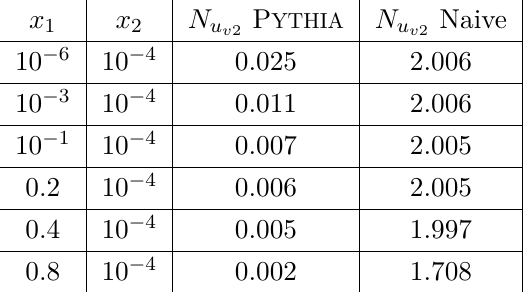
Table 9 . Integration over R uuu response function with respect to x 3 at fixed x 1 , x 2 . In the ideal situation when the GS sum rules are perfectly satisfied N u